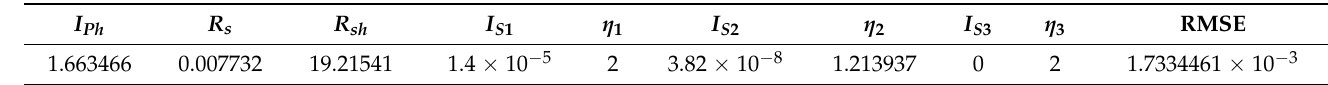
Table 6. Optimal values of extracted parameters by HPO technique for the triple-diode model of STM6-120/36.